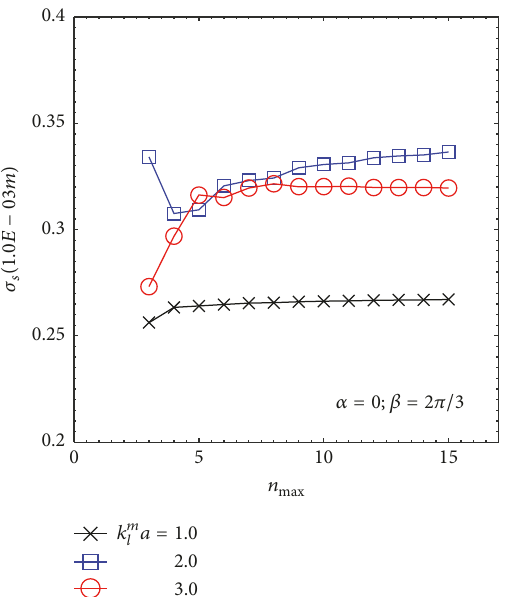
Figure 3: Convergence study of the CP method using the debonding case considered in [13]. In the CP method, the stiffness 𝐾 𝑛 /𝐾 ∗ 𝑛 = /𝐾 ∗ = 10 −6 represents the debonding. In this work, 𝐾 ∗ 𝐾 𝑡 𝑡